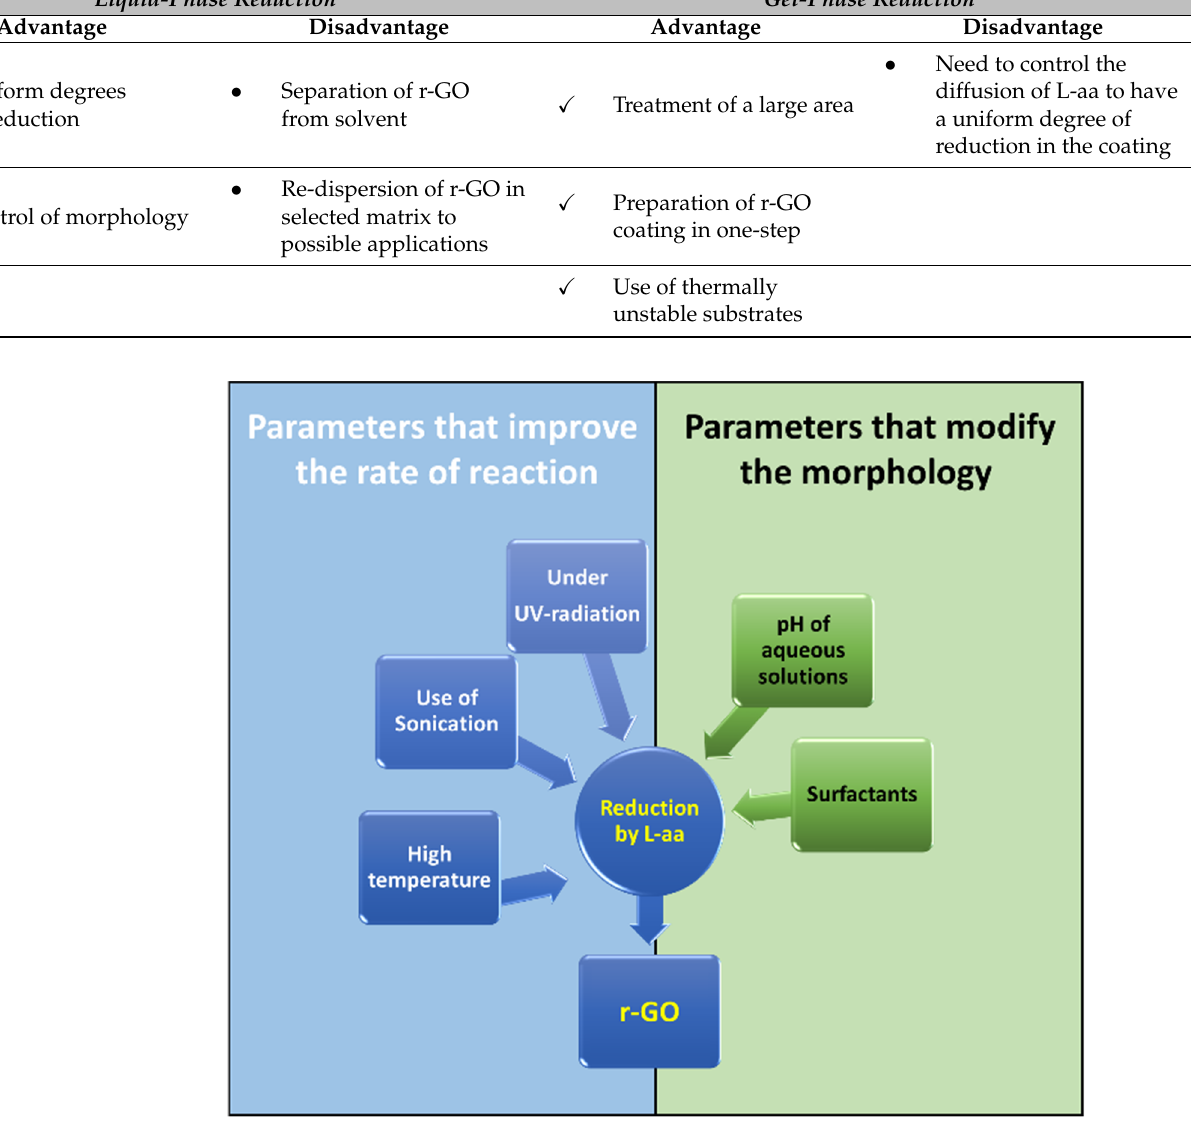
Figure 6. Parameters that act on the reduction mechanism.